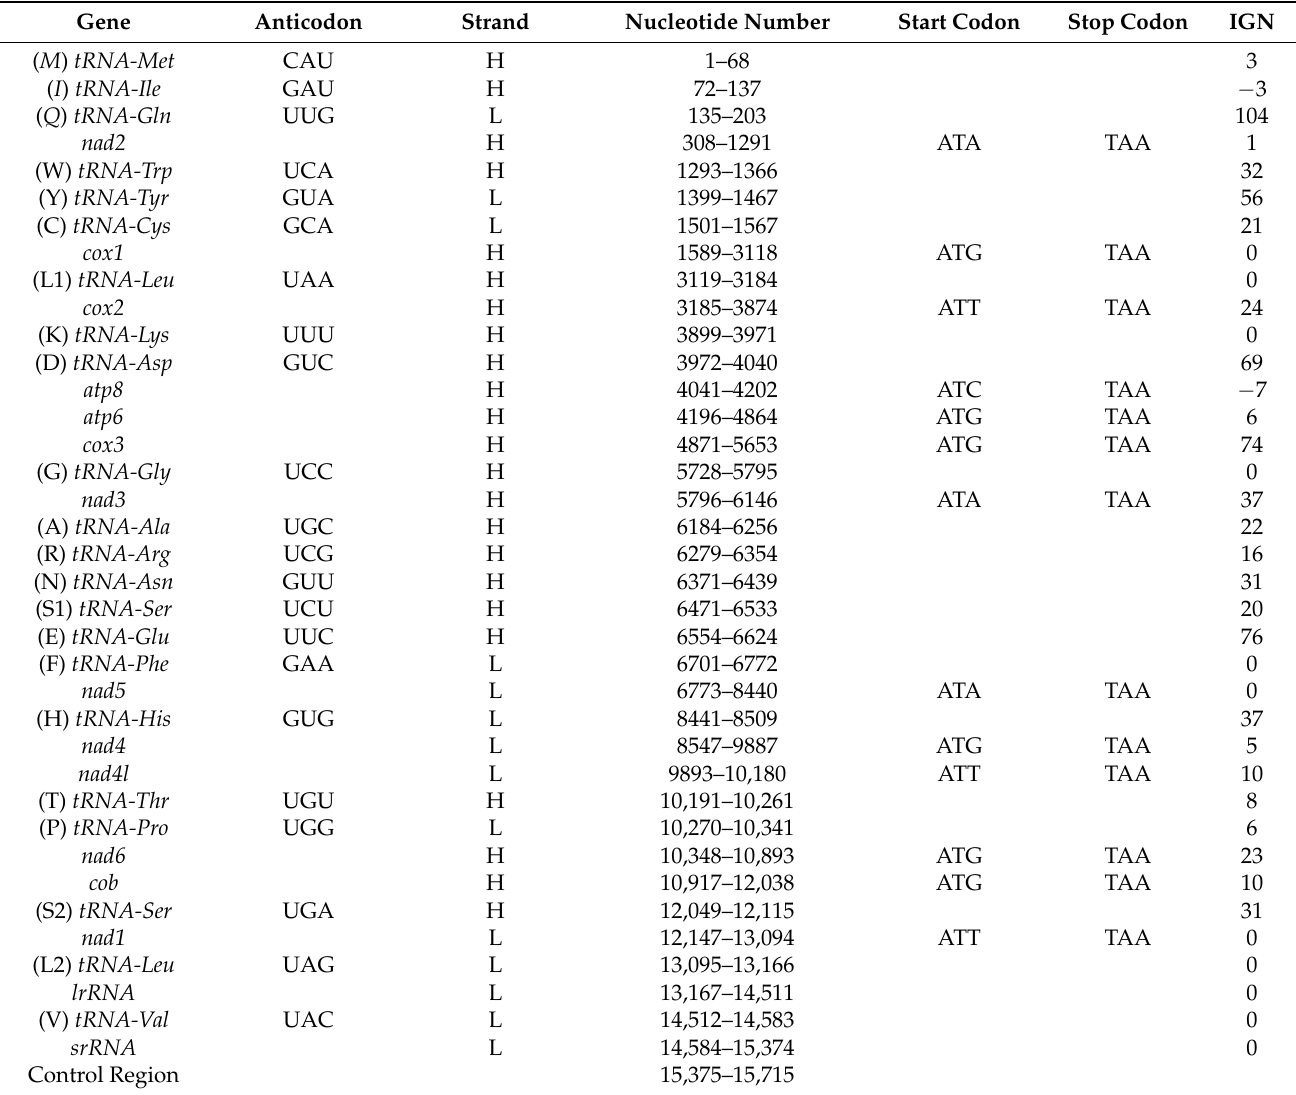
Table 2. Annotation of the complete mitogenome of Tapinoma ibericum . IGN: intergenic nucleotides. Negative values refer to overlapping